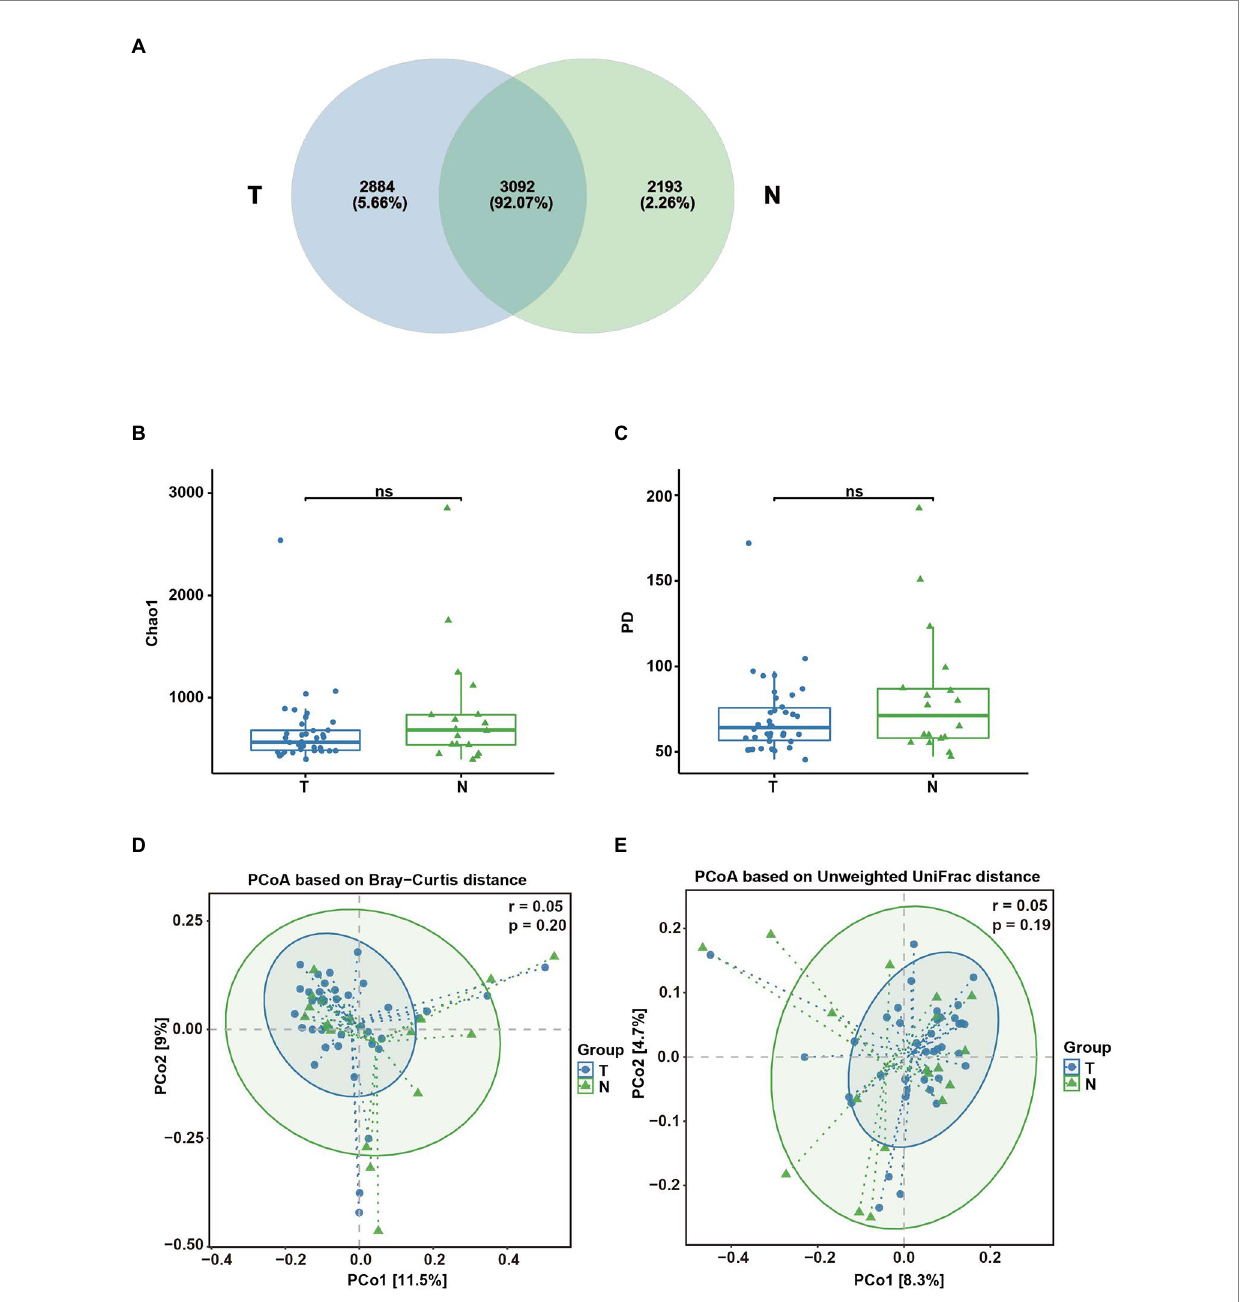
FIGURE 5 Analysis of the diversity of the uterine microbial composition in the embryo-arrest and normal pregnancy groups. (A) Venn diagram of the numbers of OTUs identified in the two groups. (B) α -diversity of chao1. (C) α -diversity of the PD whole tree. (D) PCoA plot of the Bray–Curtis distance between the two groups. (E) PCoA plot of unweighted Uni-Frac distance between the two groups. T, embryo-arrest group; N, normal pregnancy group. Significance was tested with the Wilcoxon rank-sum